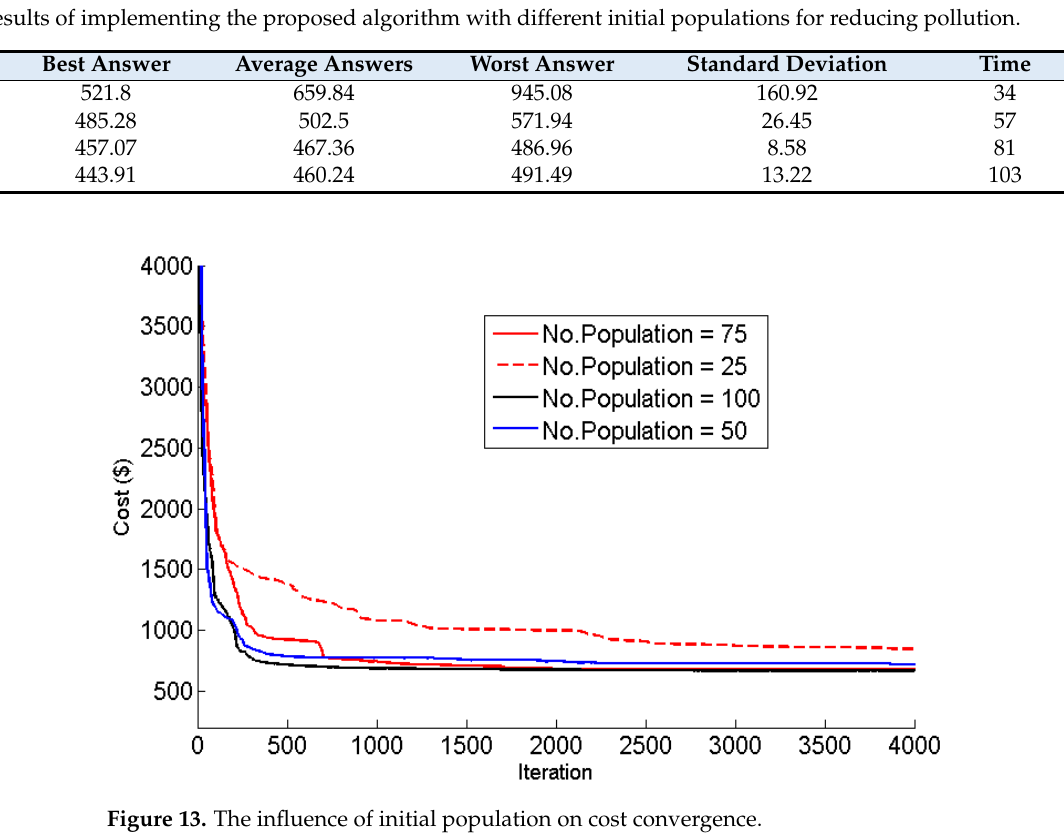
Figure 13. The influence of initial population on cost convergence.